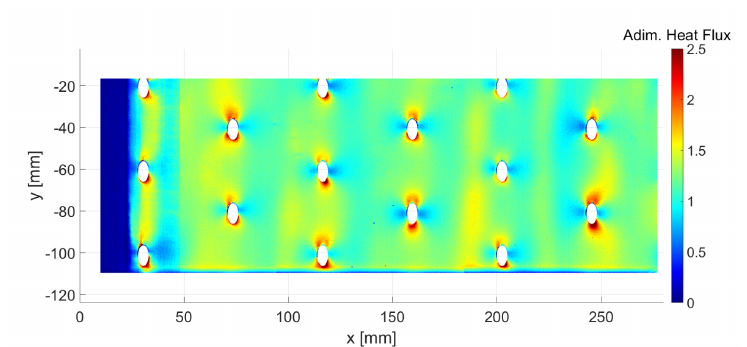
Figure 9. Heat flux distribution generated by the conductive paint.